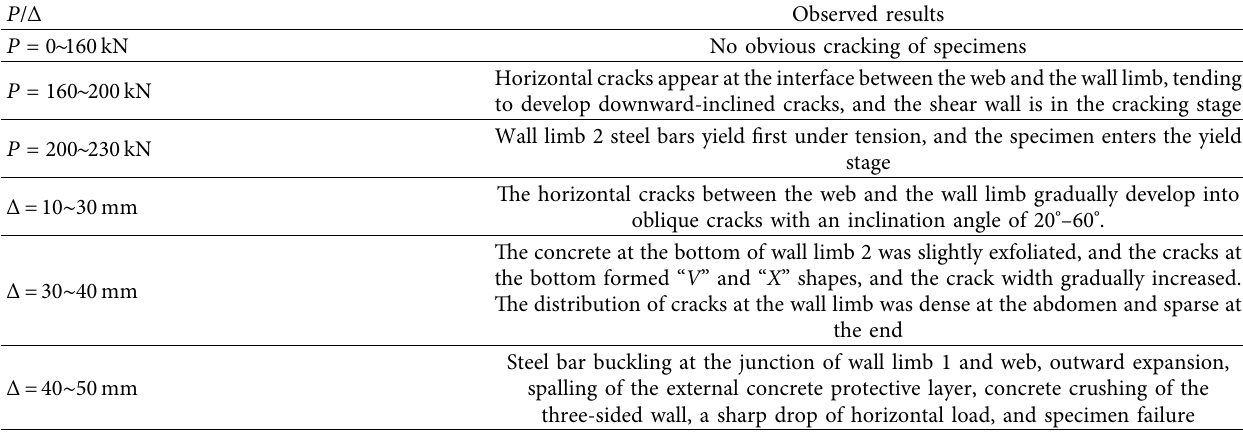
Table 3: Experimental phenomena of URC-X.